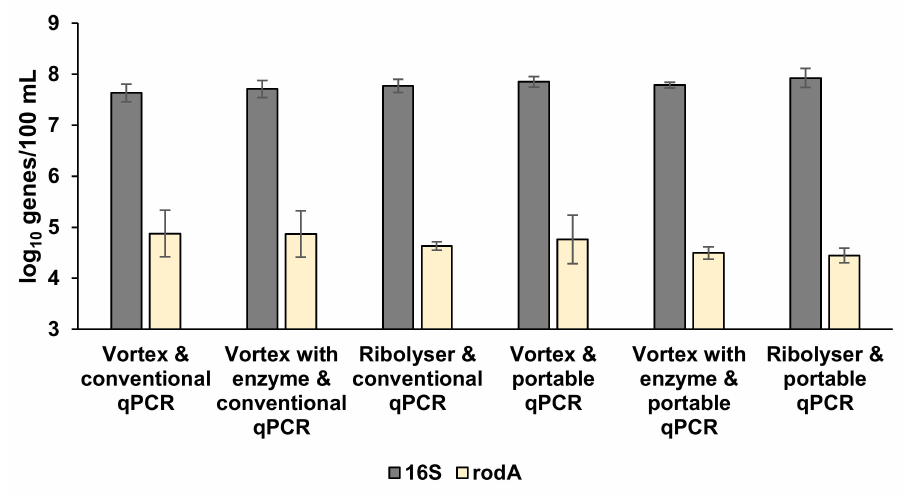
Figure 2. 16S rRNA and rodA marker gene copies per 100 mL of river water quantified with different DNA extraction methods and qPCR instruments. Error bars indicate the standard deviation of